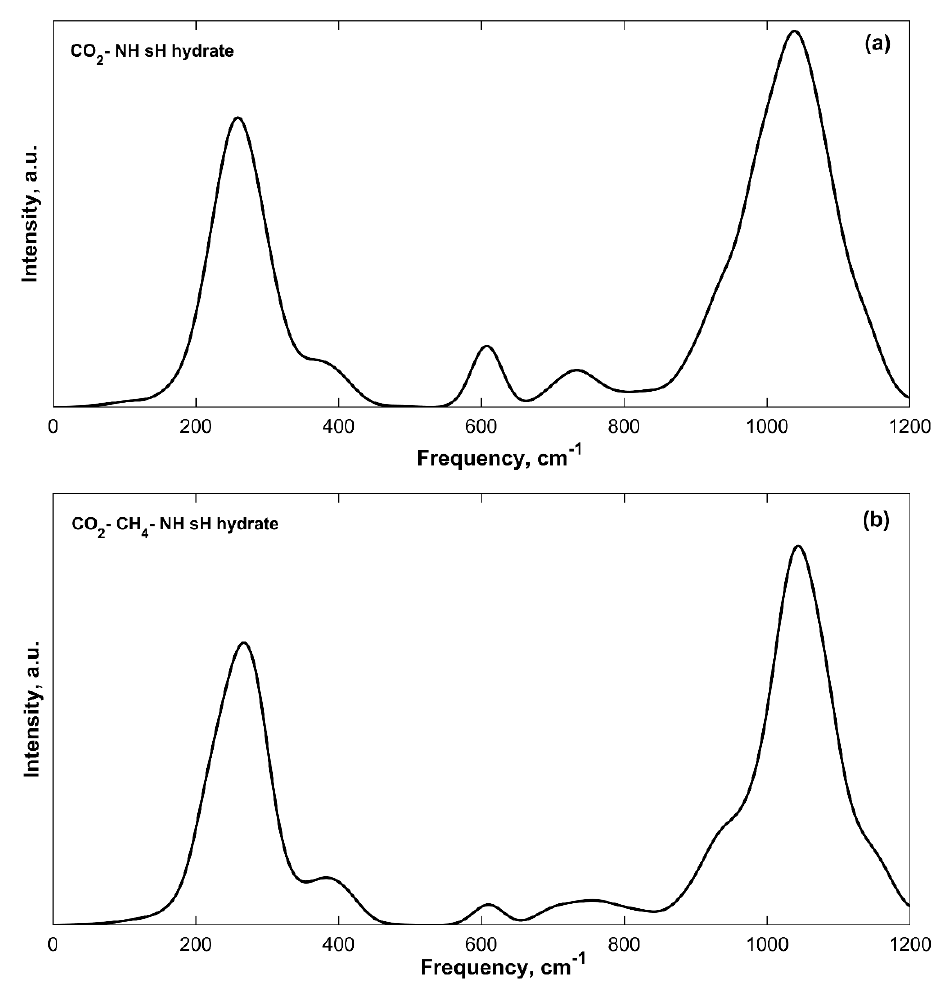
− 1 ( a ) and 610 cm − 1 ( b ) in sH gas hydrates at 3